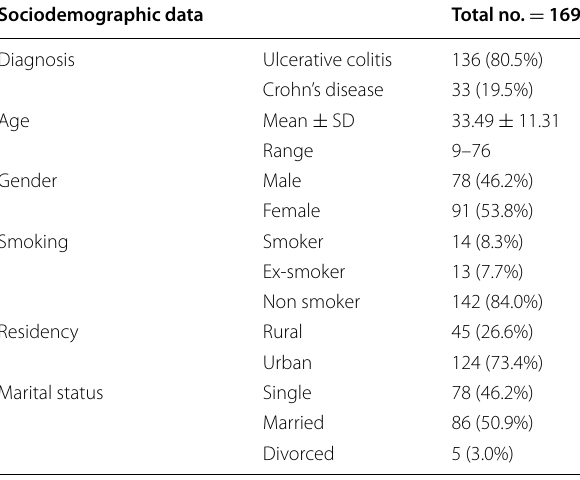
Table 4 Sociodemographic characteristics of our patients